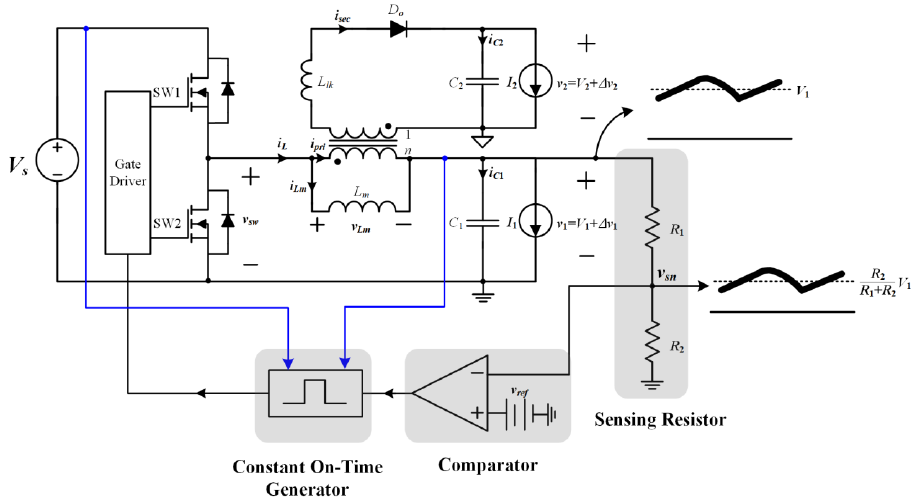
Figure 5. Block diagram of the COT controlled fly-buck converter.